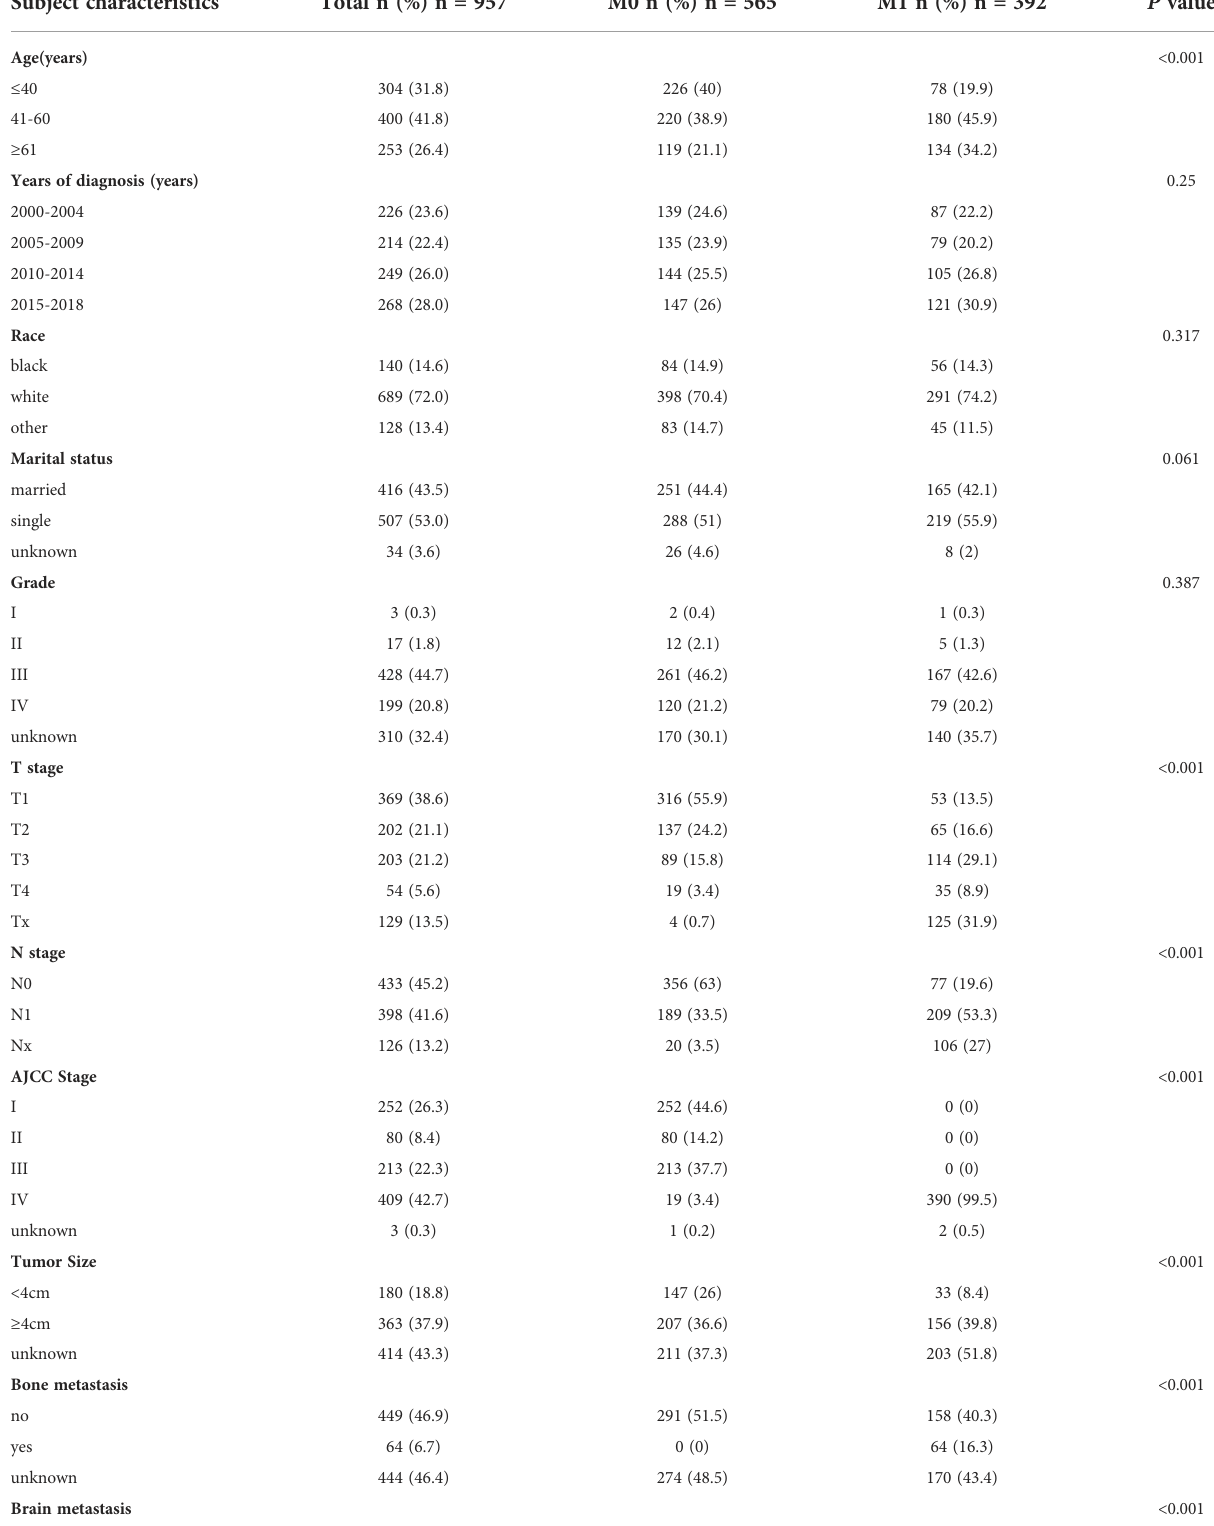
TABLE 1 Demographic and clinical characteristics for neuroendocrine cervical carcinoma patients diagnosed with and without distant metastasis (2000 –